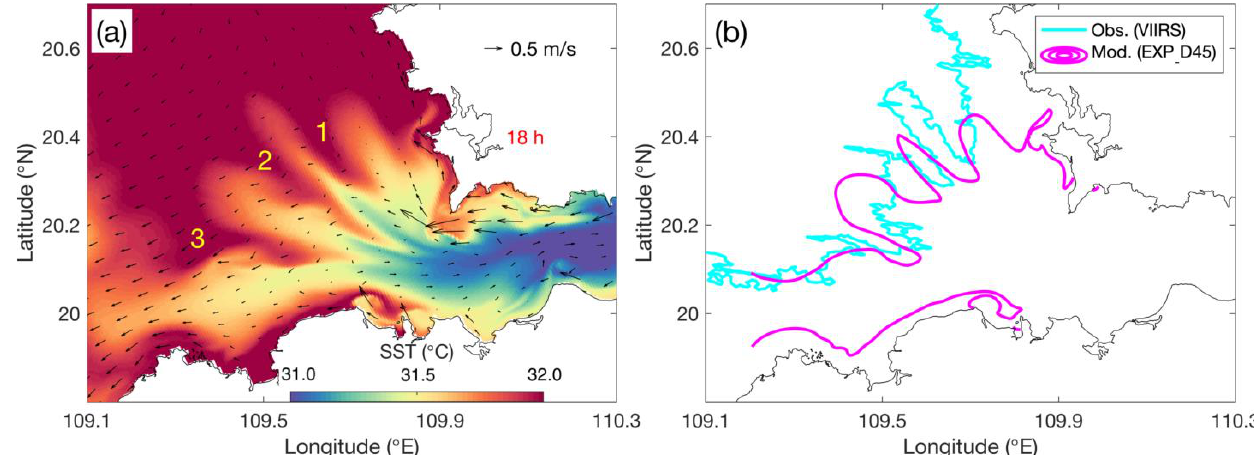
Figure 5. ( a ) SST field superposed by surface current vectors modeled by EXP_D45. ( b ) Direct comparison between the EXP_D45 modeled (purple contours) and VIIRS observed (Cyan contours) peripheries of warm water tongues. Note: “1”, “2”, and “3” are used to mark off three branches of the simulated trident-shaped warm water tongue, respectively.